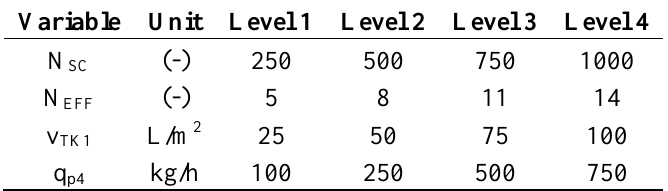
Table 1. Optimizing variables and corresponding